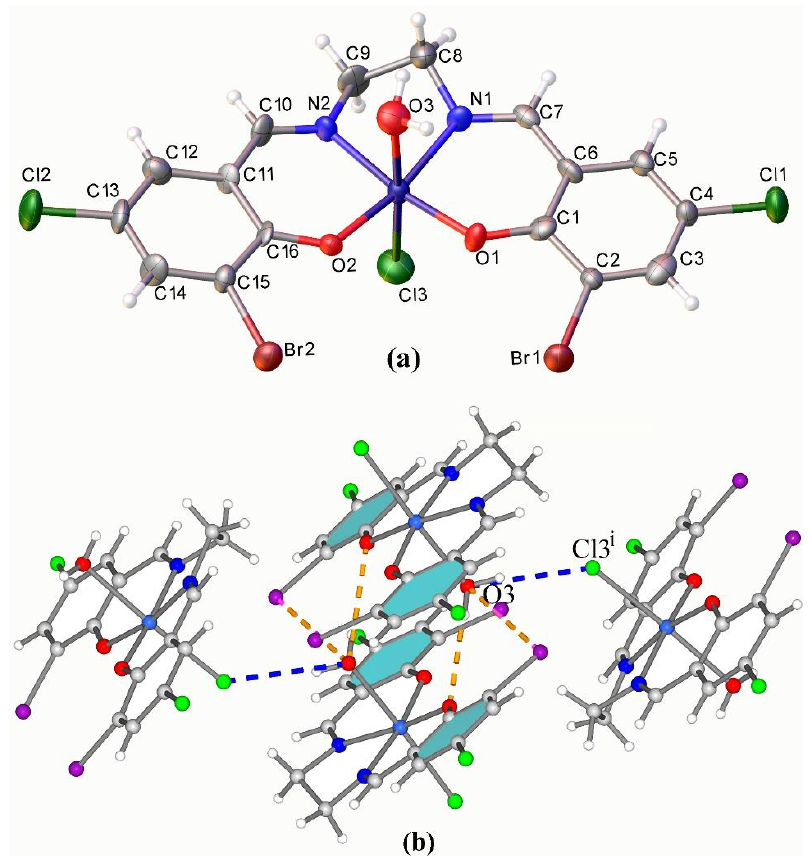
Figure 1. ( a ) The molecular structures of compound 1 , showing the atomic displacement parameters at 50% probability. ( b ) Ball-and-stick representation of H-bonded supramolecular dimer network of compound 1 .